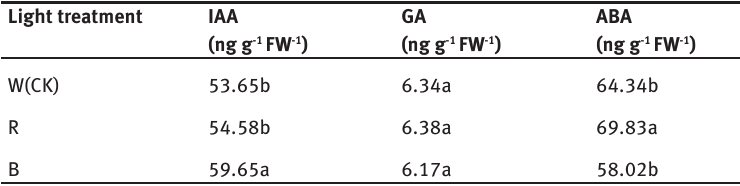
Table 5: Effects of 24 h continuous light on phytohormone content in pakchoi. Light